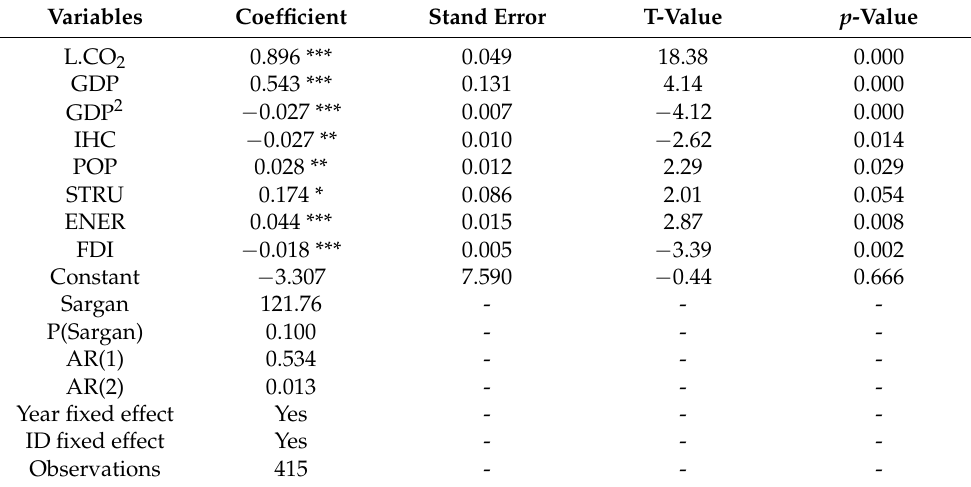
Table 7. System GMM